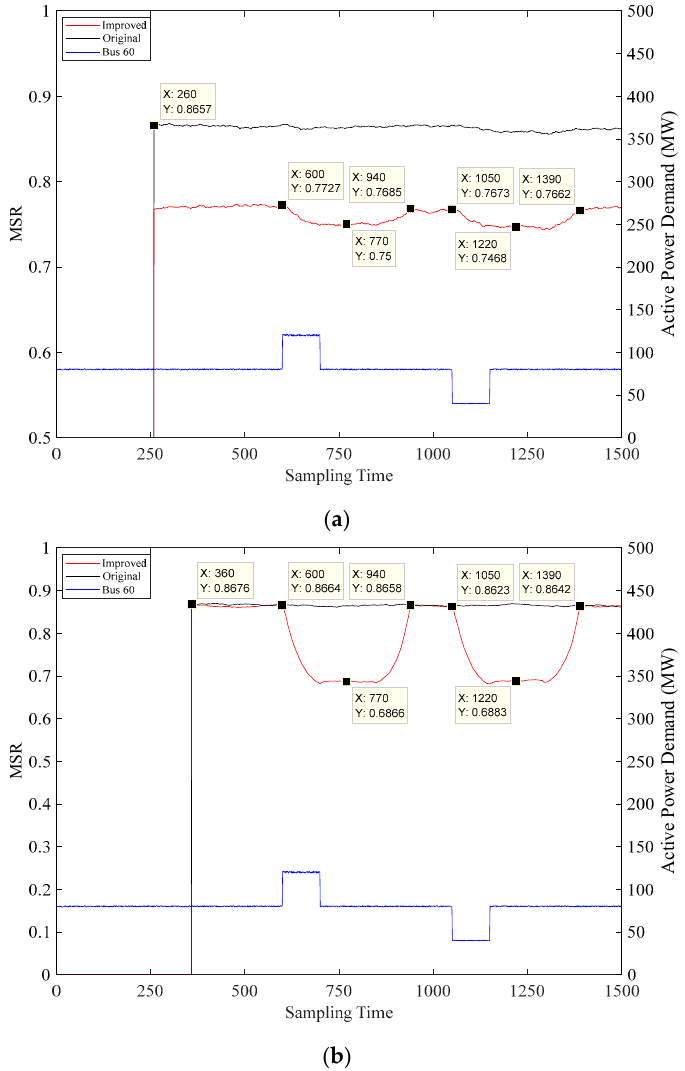
Figure 3. ( a ) Swell and sag signals (in the situation with heavy noise), ( b ) swell and sag signals (in the situation with missing data), MSR- t curves of the improved and original event detectors using voltage phase angles [30]. (Reproduced with permission from Fujia Han, IEEE Proceedings; published by IEEE, 2018.)